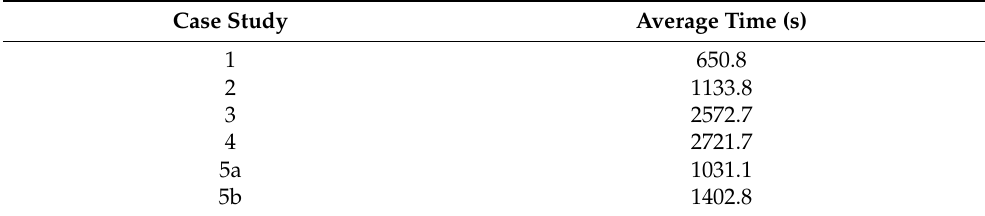
Table 12. Average computation times from MOAIS.